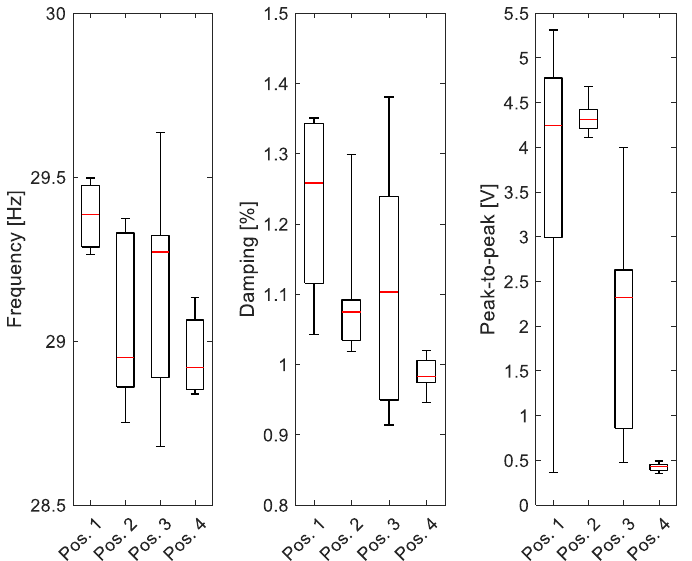
Figure 7. Box plots of the frequency, damping ratio, and peak-to-peak voltage registered in indoor tests with different drops’ impact positions and a full